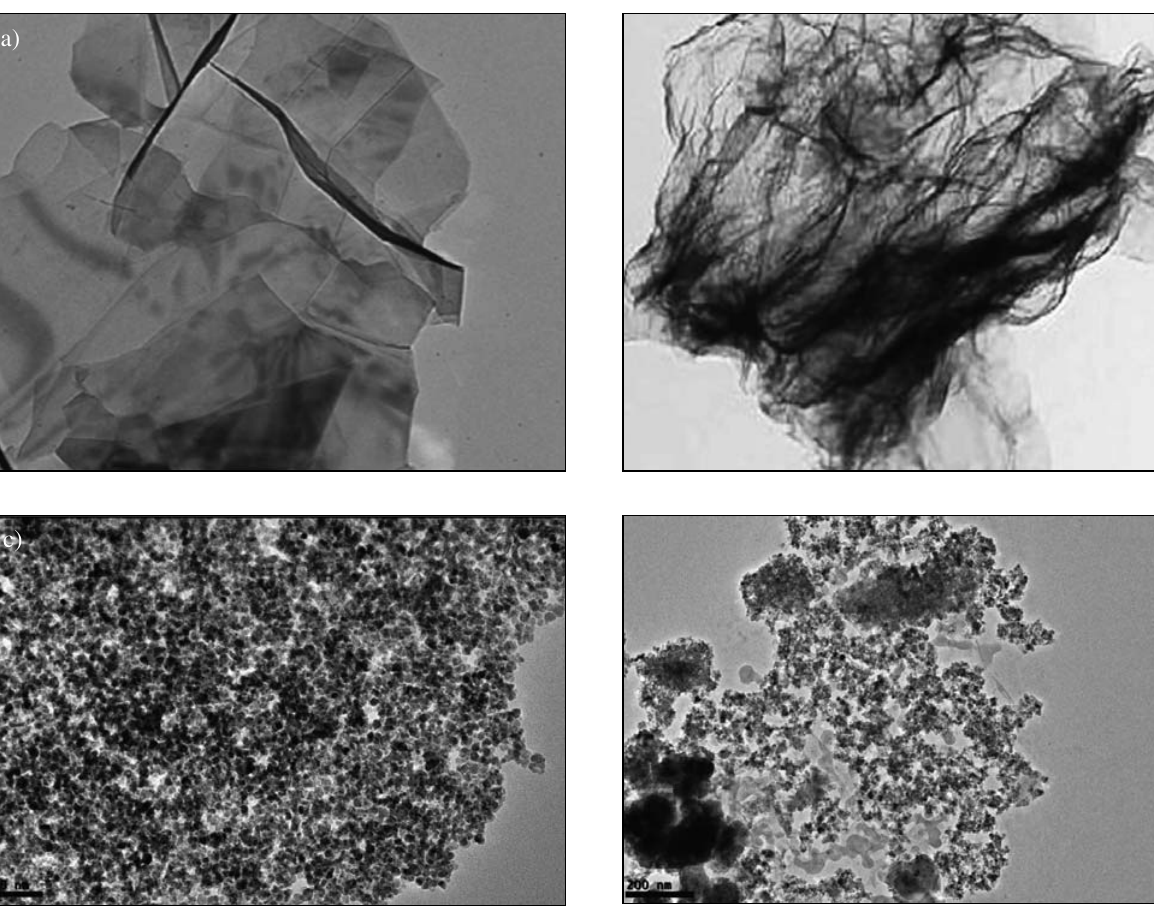
O and (d) NiFe 2 4